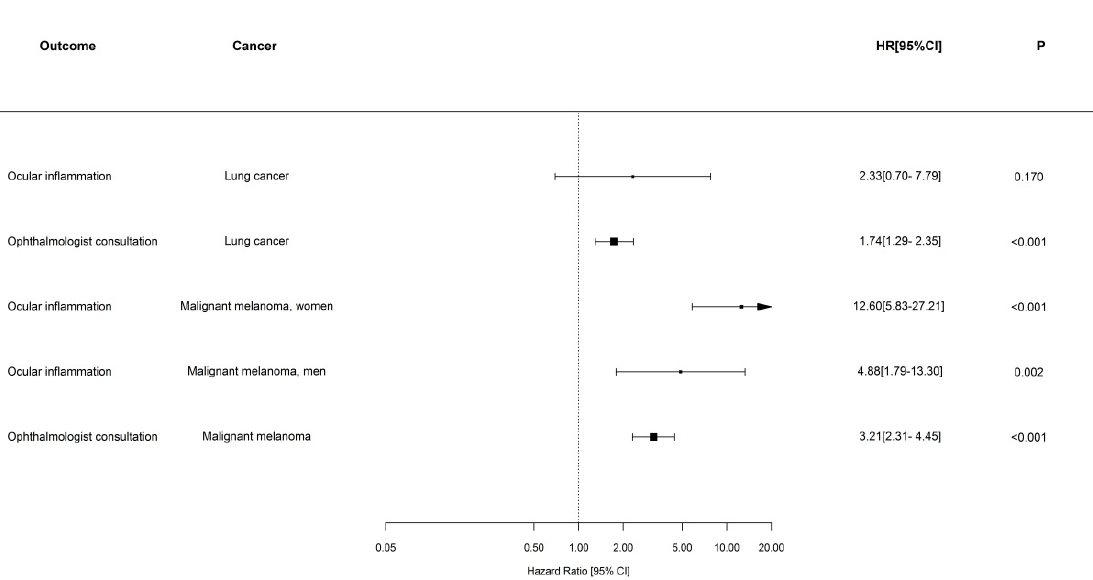
Figure 3. Hazard ratios comparing risk of first-time ophthalmologist consultation and ocular inflam- mation comparing patients with and without ICI